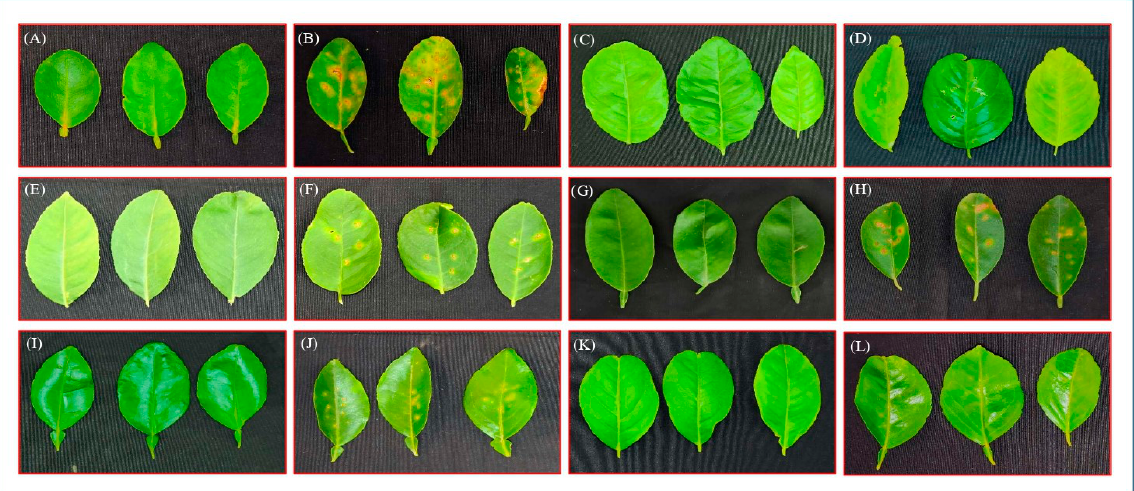
Figure 1. Citrus canker disease symptoms developed on the leaves of susceptible and resistant genotypes of citrus incited by X . citri pv. citri via artificial inoculation (40 days after inoculation). Highly susceptible genotype: ALC-35 lime ( A ) healthy leaves and ( B ) infected leaves; immune: Kagzi Kalan lemon ( C ) healthy leaves and ( D ) infected leaves; moderately susceptible: Konkan Seedless lemon ( E ) healthy leaves and ( F ) infected leaves; susceptible genotype: Pusa Udit lime ( G ) healthy leaves and ( H ) infected leaves; moderately resistant genotype: Redblush grapefruit ( I ) healthy leaves and ( J ) infected leaves; highly resistant genotype: Marsh Seedless ( K ) healthy leaves and ( L ) infected leaves.